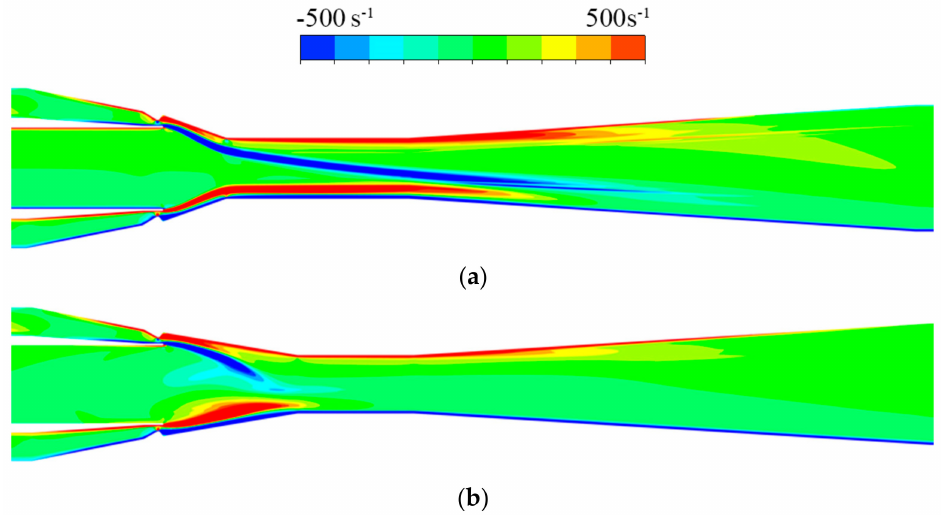
Figure 10. Internal exposure strain rate before and after optimization. ( a ) Before optimization; ( b ) After